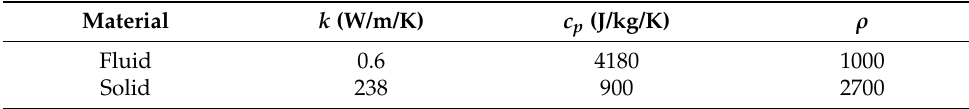
Table 1. Physical properties of